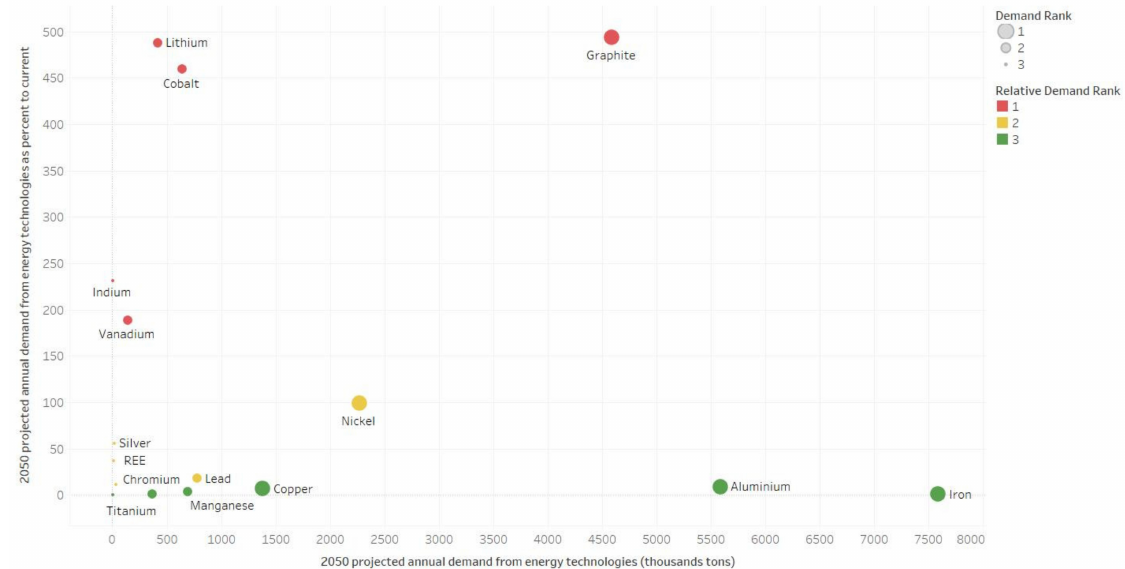
Figure 4. Scatterplot of projected 2050 annual demand versus growth as a percentage of the current rate. Symbol size corresponds to demand ranks from Table A1; colours show the relative demand ranking from Table